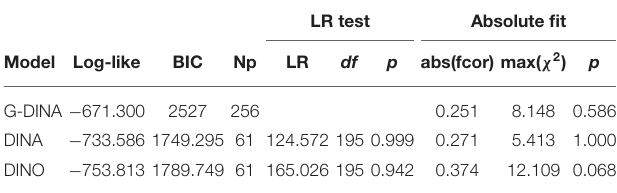
TABLE 5 | Model fit indices for different cognitive diagnosis models.